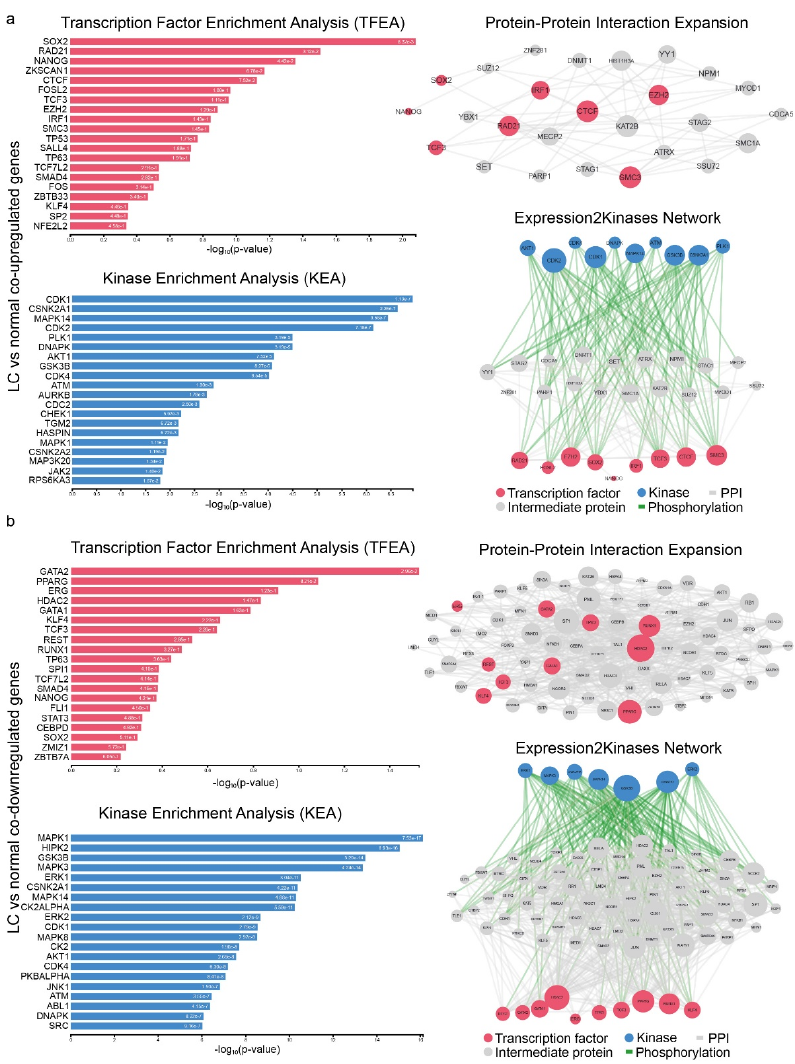
Figure 3. Upstream regulatory networks for co-upregulated ( a ) and co-downregulated ( b ) gene signatures in lung cancer vs. the normal tissue. The networks depict transcription factors (TFs, red nodes), intermediate proteins (gray nodes), and kinases (blue nodes). Gray edges indicate PPI